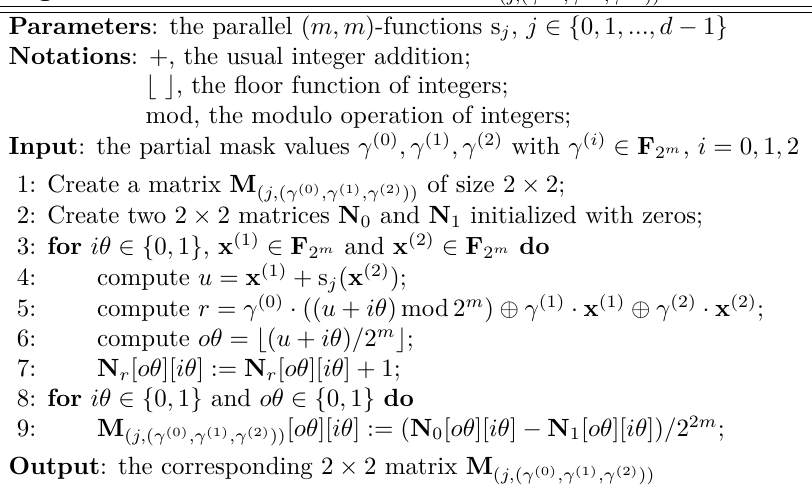
Algorithm 1 Construction of the matrix M